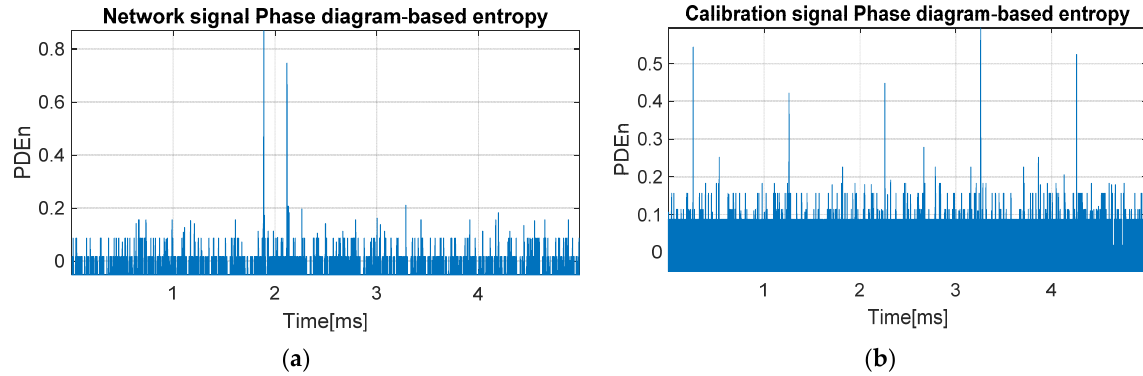
( a ) ( b ) ( ) 0.6 var r w = × ; ( b ) phase diagram-based entropy Figure 14. ( a ) Phase diagram-based entropy of the network signal for Figure 14. ( a ) Phase diagram-based entropy of the network signal for r = 0.6 × var ( w ) ; ( b ) phase diagram-based entropy of ( ) the calibration signal for r = 0.6 × var ( w ) 0.6 var r w = × . of the calibration signal for